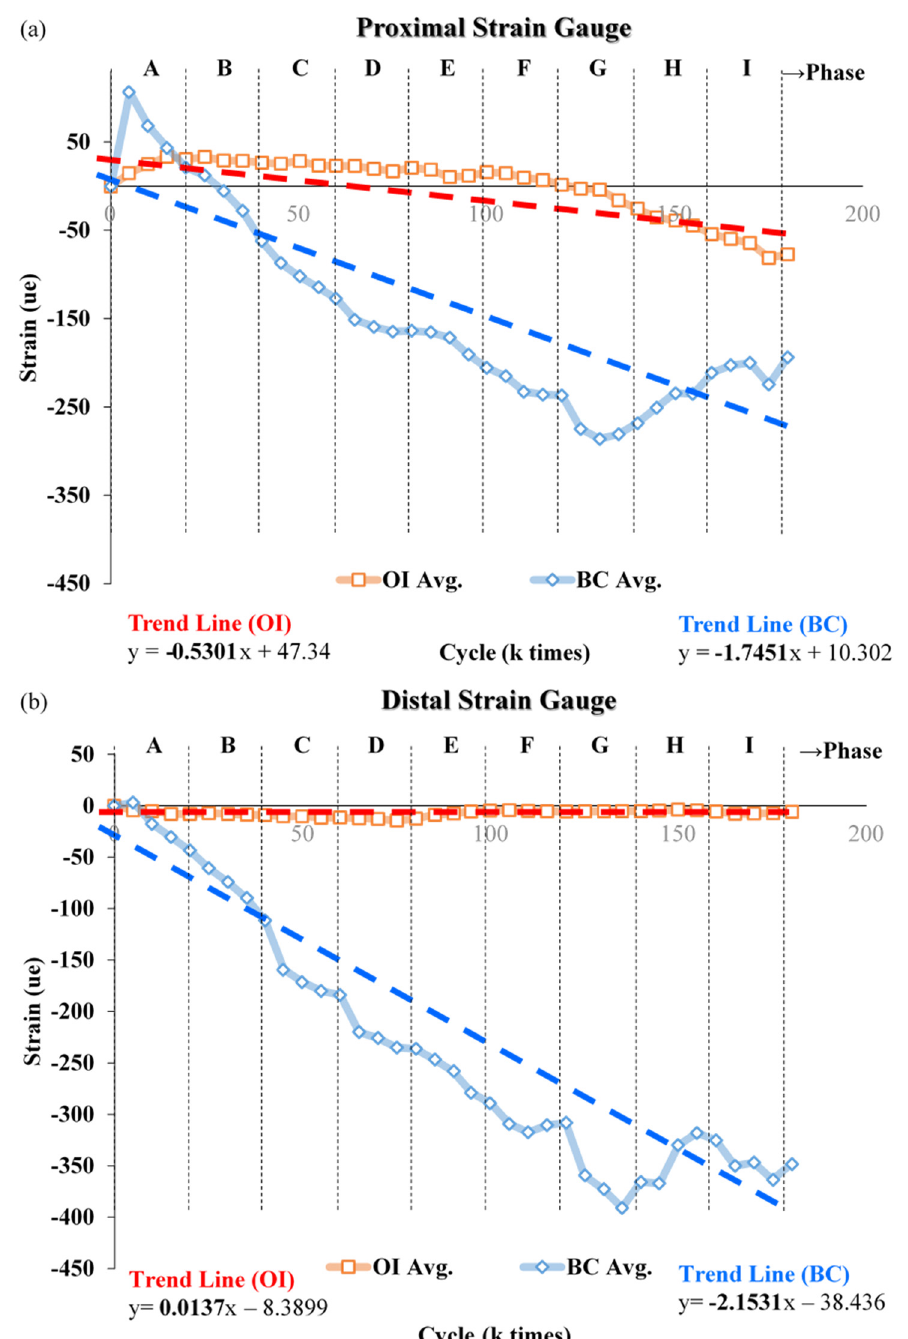
Figure 8. Change in strain with increasing load on femur repaired with the bone scaffold implant or bone cement. Across nine increases in load, the change in strain in the ( a ) proximal and ( b ) distal sites, strain values (negative) were greater in the bone cement than in the implant. Each data point is the average of 3 separate experiments.